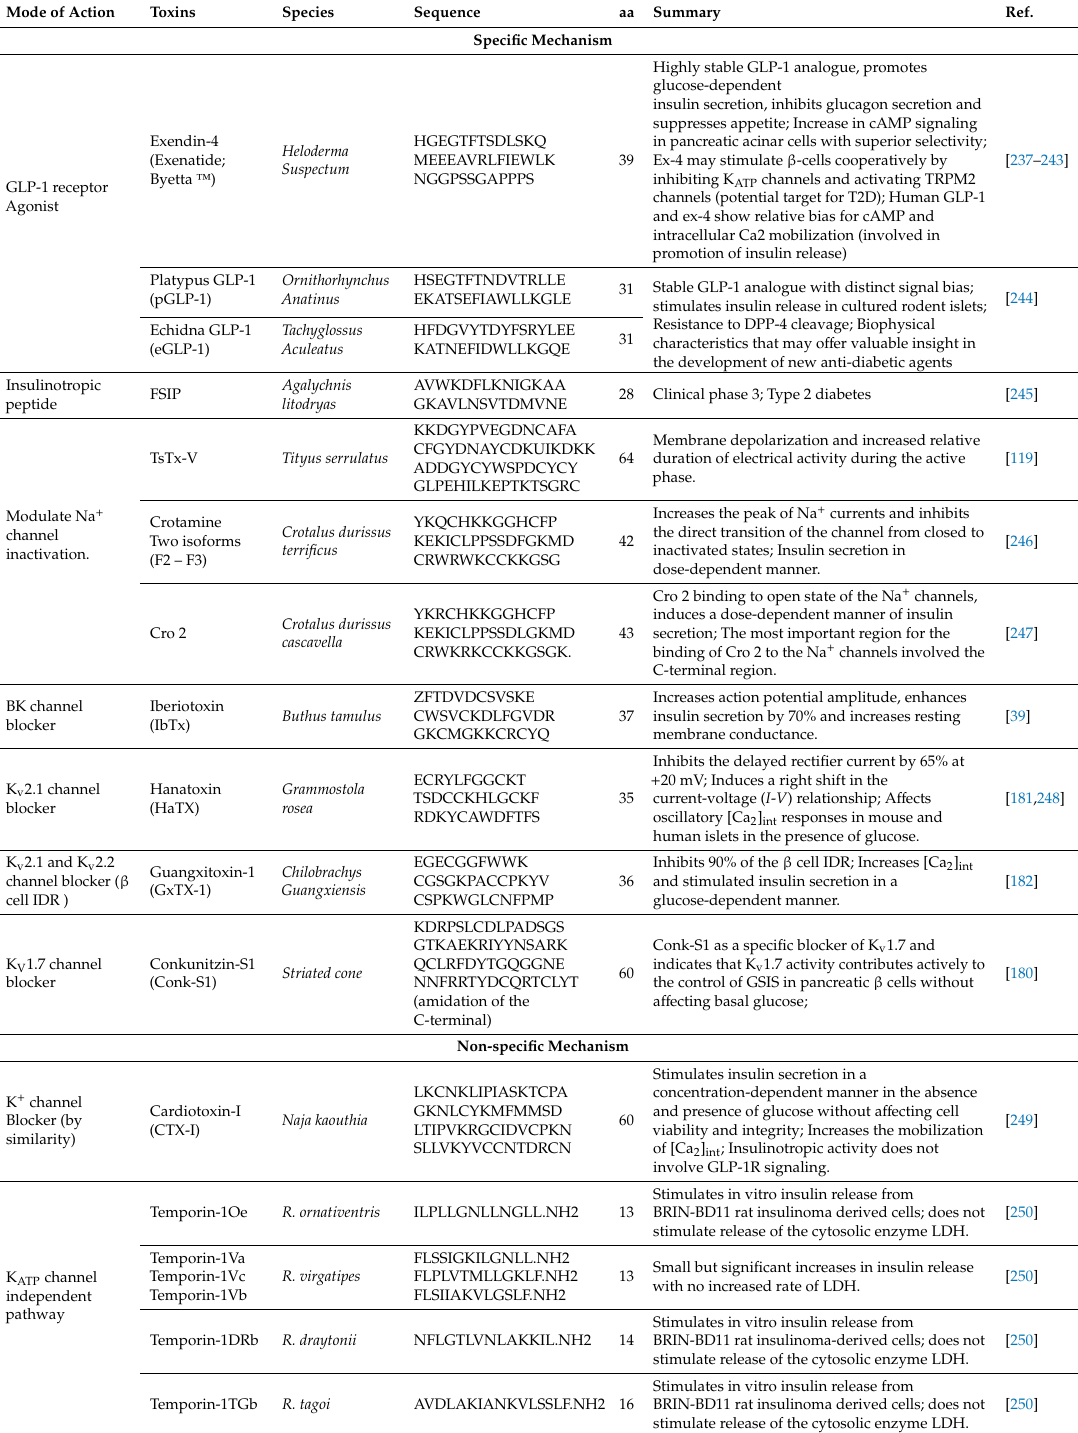
Table 1. Insulin release mechanism modulated by toxins isolated from animal